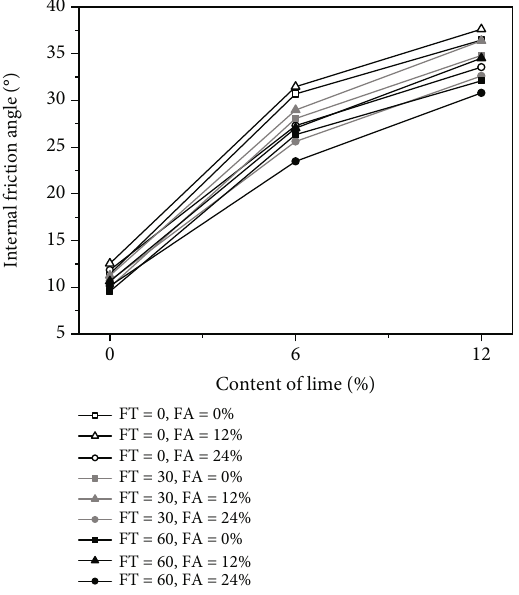
Figure 27: Internal friction angle at di ff erent lime